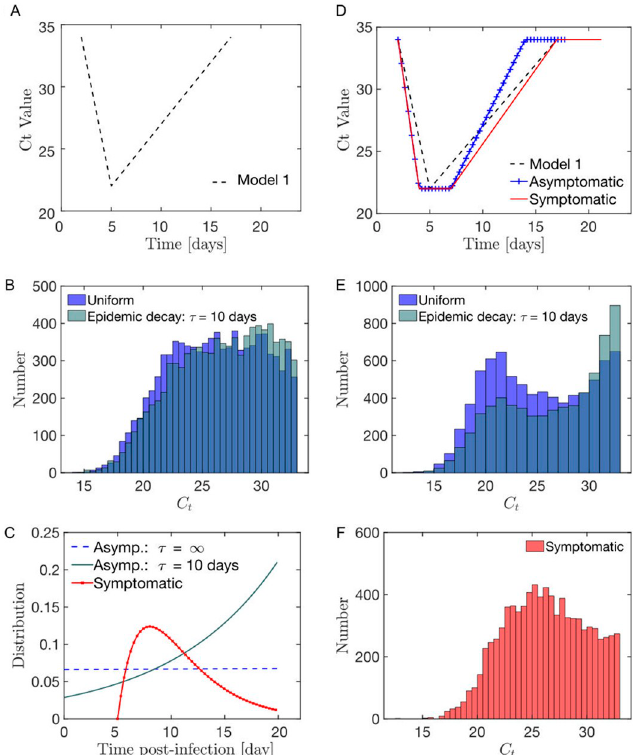
Fig 3. (A) Model 1 for the evolution of the viral load post-infection. (B) Modelled distribution in the infection age at the moment of the test for (red) symptomatic individuals as a Gamma function; (blue-cyan) fully asymptomatic (i.e. throughout the infection) individuals either as (blue) a constant if the new infections rate is a constant with time or (cyan) as an exponential if the rate of new infections decays exponentially with time (characteristic decay time τ = 10 days). (C) In the Model 1 context, the distribution of the viral load in asymptomatic individuals is relatively uniform. (D) Model 2 for the evolution of the viral load post-infection distinguishing between symptomatic and asymptomatic (combining [58] and [59]). Parameters estimate are provided in Table H in S1 Text. (E) In the model 2 context, the distribution of the viral load in asymptomatic individuals shows 2 peaks at high and low viral loads. (F) The distribution of the viral load in symptomatic individuals is less bimodal than the observed asymptomatic